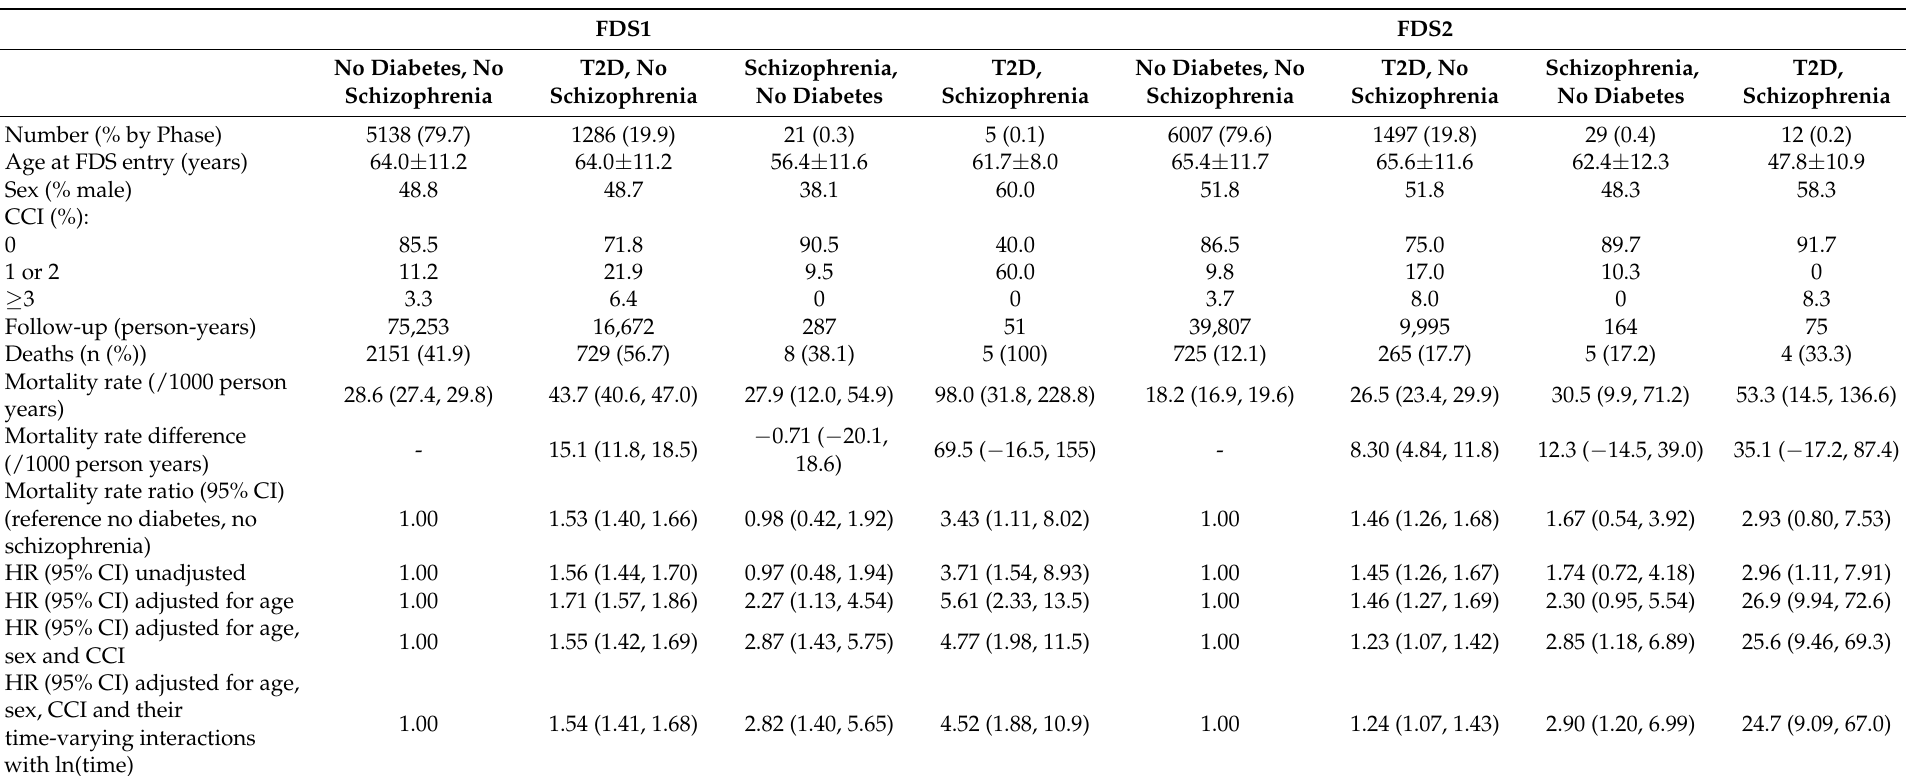
Table 1. Baseline characteristics and subsequent mortality in participants with type 2 diabetes and matched individuals without diabetes by prevalent schizophrenia status for each FDS Phase. FDS1